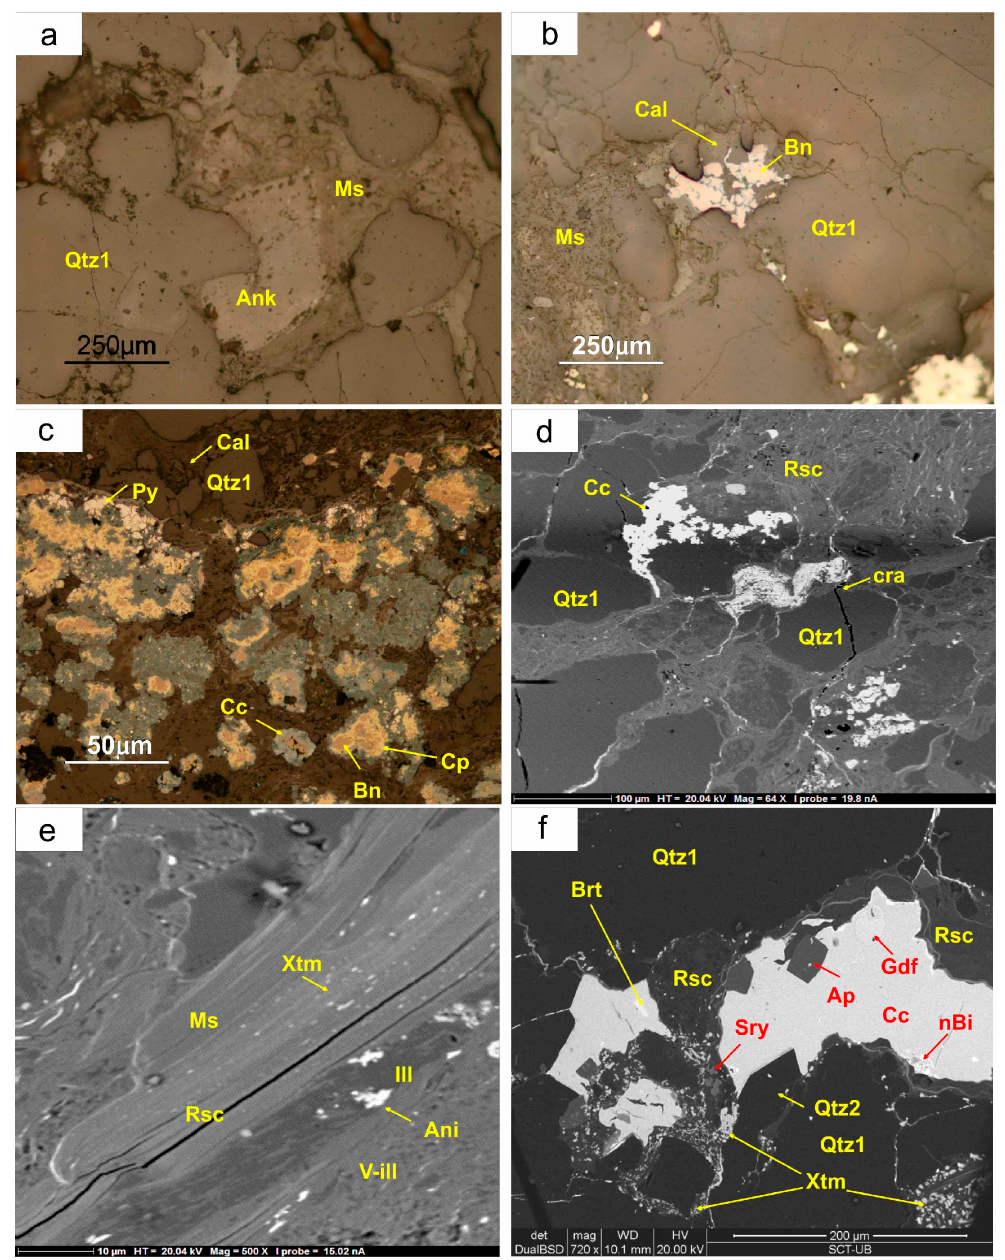
Figure 6. ( a ) Development of ankerite (Ank) rhombohedral crystals by replacement of the groundmass, with muscovite (Ms) and quart (Qtz1); note some small quartz crystals intergrown with ankerite (Ank) in the last bands; ( b ) Replacement of calcite cement (Cal) between detrital quartz (Qtz1) by bornite (Bn); ( c ) Advanced replacement of calcite cement and detrital grains by ores: pyrite (Py), bornite (Bn) mantled by chalcopyrite (Cp) and chalcocite (Cc); ( d ) Detrital quartz (Qtz1) in a roscoelite groundmass (Rsc) with chalcocite (Cc) and crandallite (Cra) scattered grains or filling slaty cleavage; ( e ) “illite” (Ill) and muscovite (Ms) plates replaced by “vanadian illite” (V-Ill) and roscoelite (Rsc), associated with xenotime (Xtm) and anilite (Ani); ( f ) Detrital quartz (Qtz1) overgrown by euhedral quartz (Qtz2) and apatite (Ap); clayish groundmass is replaced by roscoelite (Rsc) and large amounts of xenotime (Xtm), with minor schreyerite (Sry). Note the replacement of gersdor ffi te (Gdf) by chalcocite (Cc), native bismuth (nBi) and barite (Brt). (a) to (c), reflected light images, PPL; (d) to (f), SEM images, mode